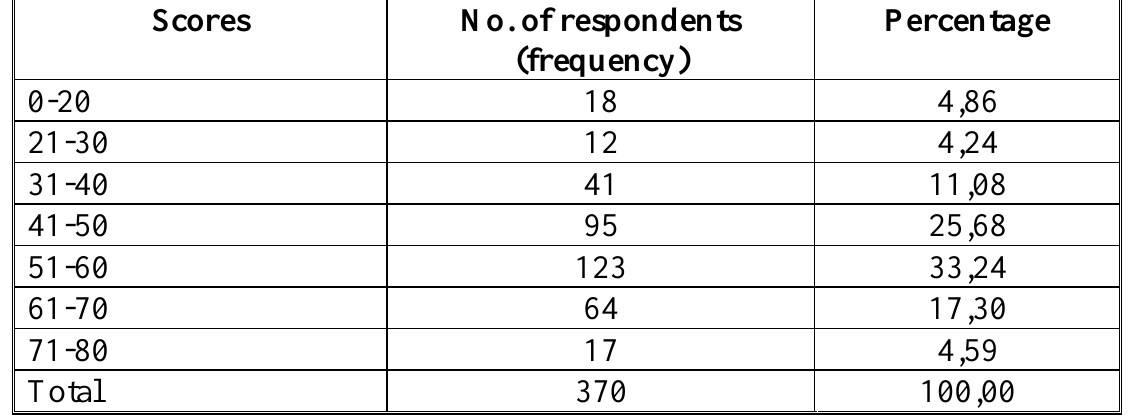
Summary of self-image scores of